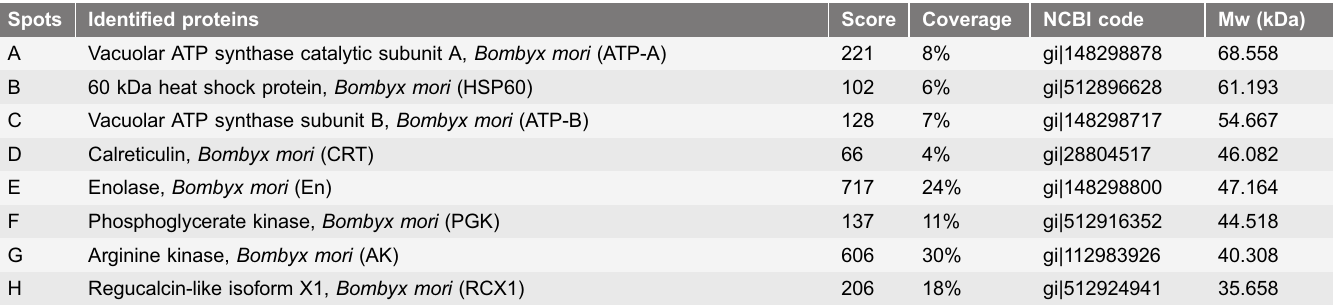
Table 2. Identification of B. mori proteins separated by 2-DE.